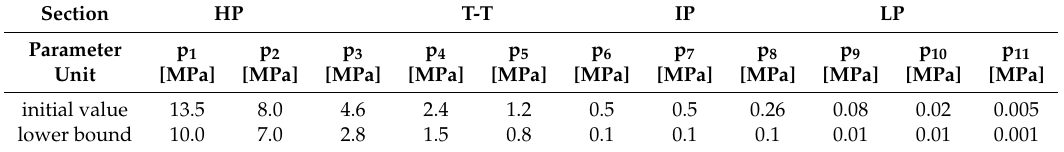
Table 3. The initial values of the decision variables, together with their lower